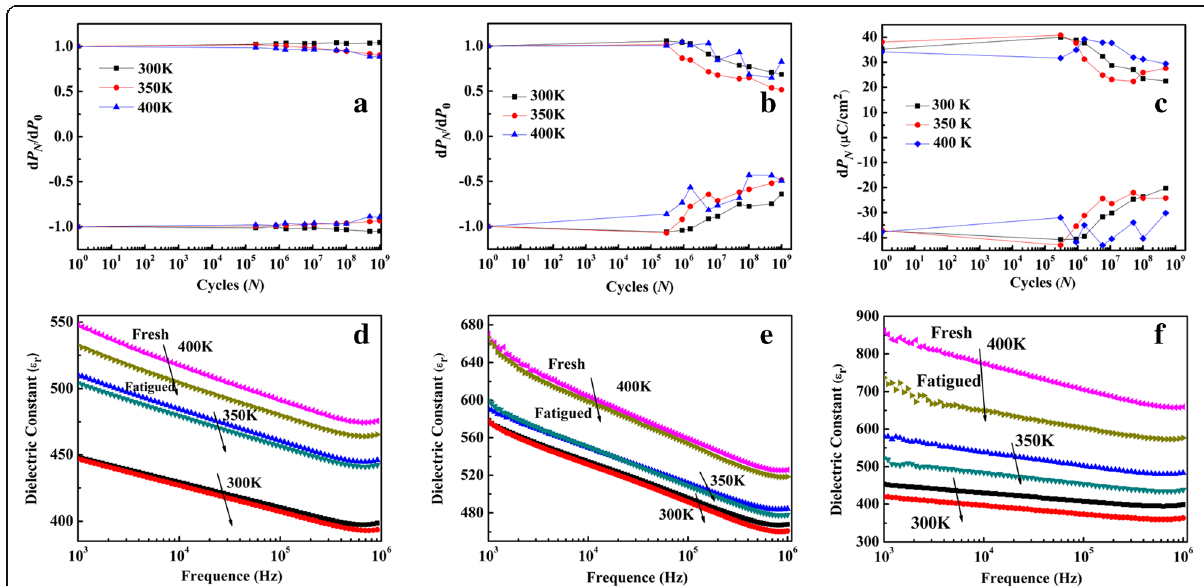
BNTM-2; c , f for BNTM-3